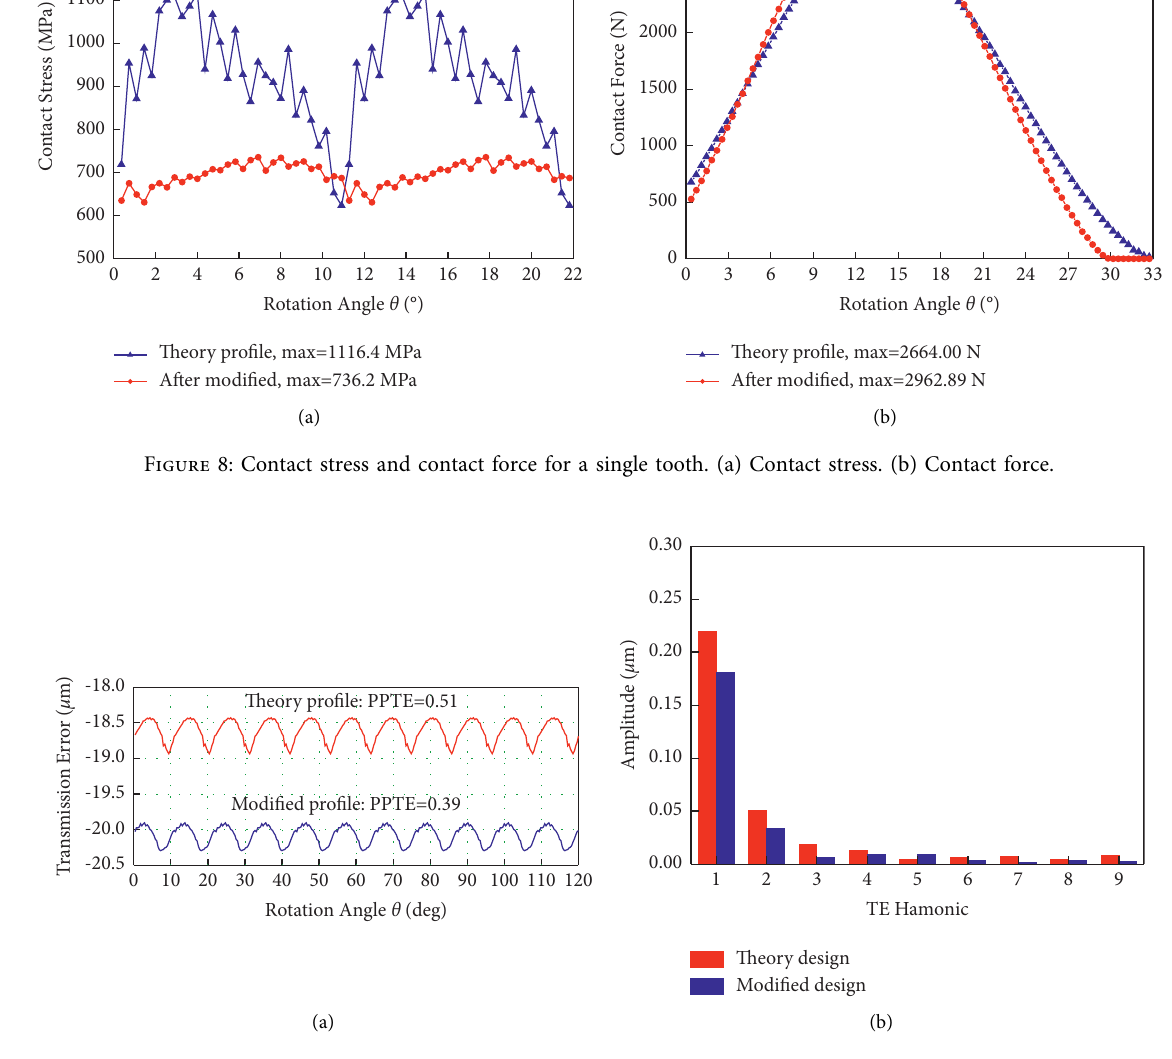
Figure 9: Transmission error of theory and modification design.